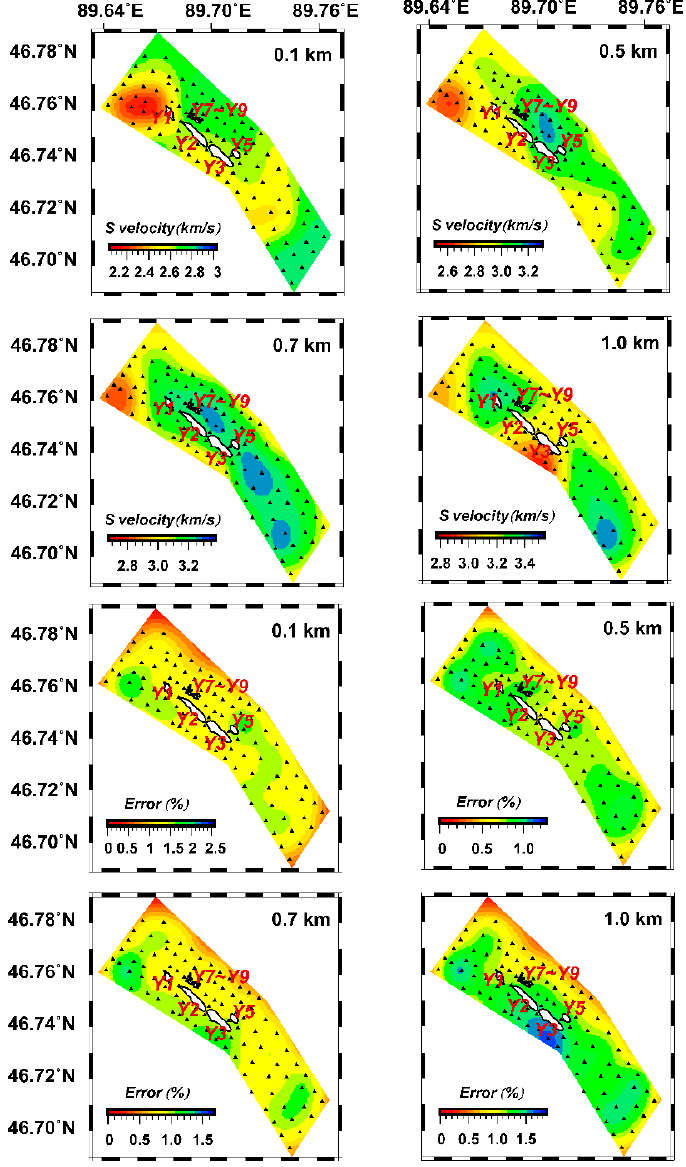
Figure 7. The Vs model and approximated model errors from the bootstrap inversion. The final Vs model is averaged from the 50 models inverted using bootstrapped datasets, and is shown at 0.1, 0.5, 0.7 and 1.0 km, respectively in the top panels. The model errors approximated from the standard deviation are plotted in the lower panels. The errors are in general in the range of ~0.2% to 2.7%. (Note outside the array there is no ray coverage. The < 0.2% errors reflect smoothing and regularization in the effective regions and therefore may not be representative of robust regions). White areas with black solid lines represent the surface location of ore hosting intrusions Y1–Y9.